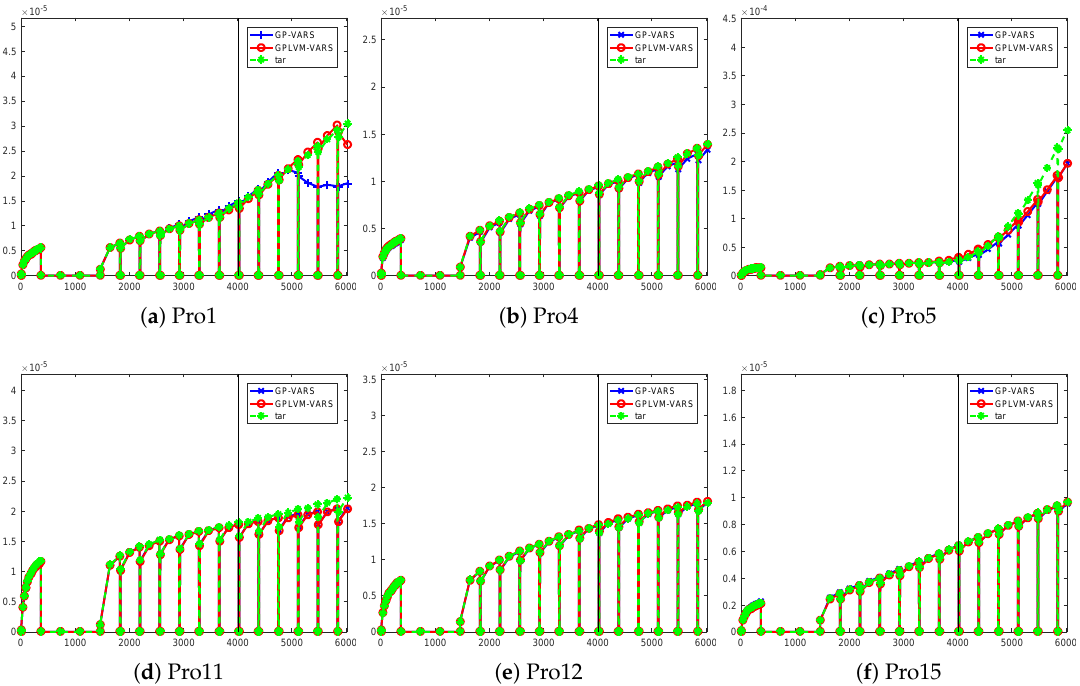
Figure 8. Comparison of WWCT with 4000 training and 2000 testing data for six wells (the black vertical line indicating present day).